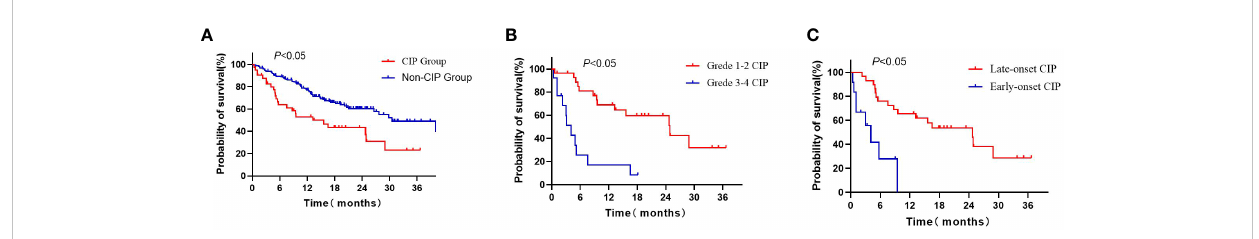
FIGURE 2 Kaplan – Meier curves for OS of advanced NSCLC patients: (A) Kaplan – Meier curves for OS of CIP patients and non-CIP patients; (B) Kaplan – Meier curves for OS of grade 1-2 CIP and grade 3-4 CIP patients; (C) Kaplan – Meier curves for OS of late-onset CIP and early-onset CIP patients. CIP, imune checkpoint inhibitor-related pneumonitis; OS, overall survival.